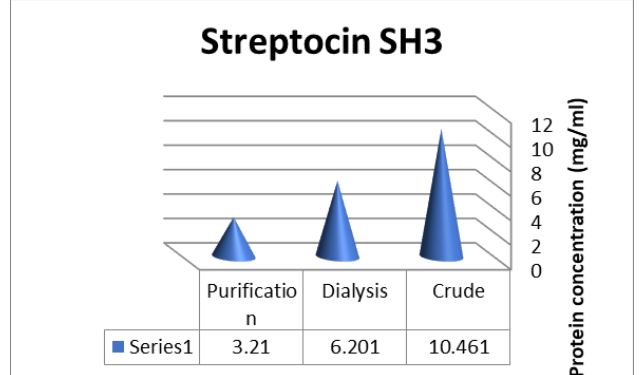
Figure 3 : Protien concentration measured by Lowry method Spectrum activity of streptocin